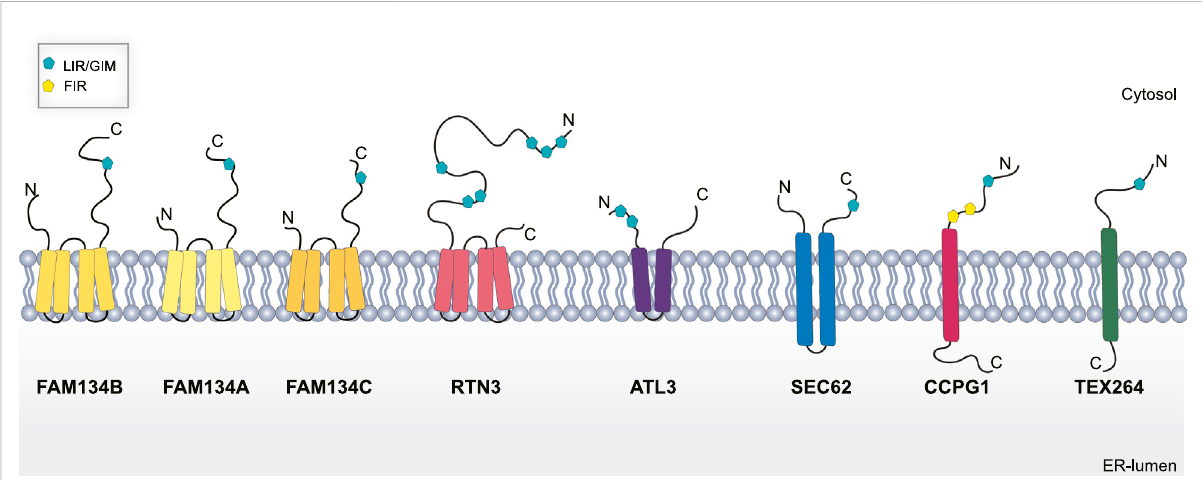
FIGURE 2 SchematicrepresentationofER-phagyreceptors.Abbreviations:LIR/GIR,LC3/GABARAPinteractingregion;FIR,FIP200interactingregion;C,C terminal domain; N, N-terminal